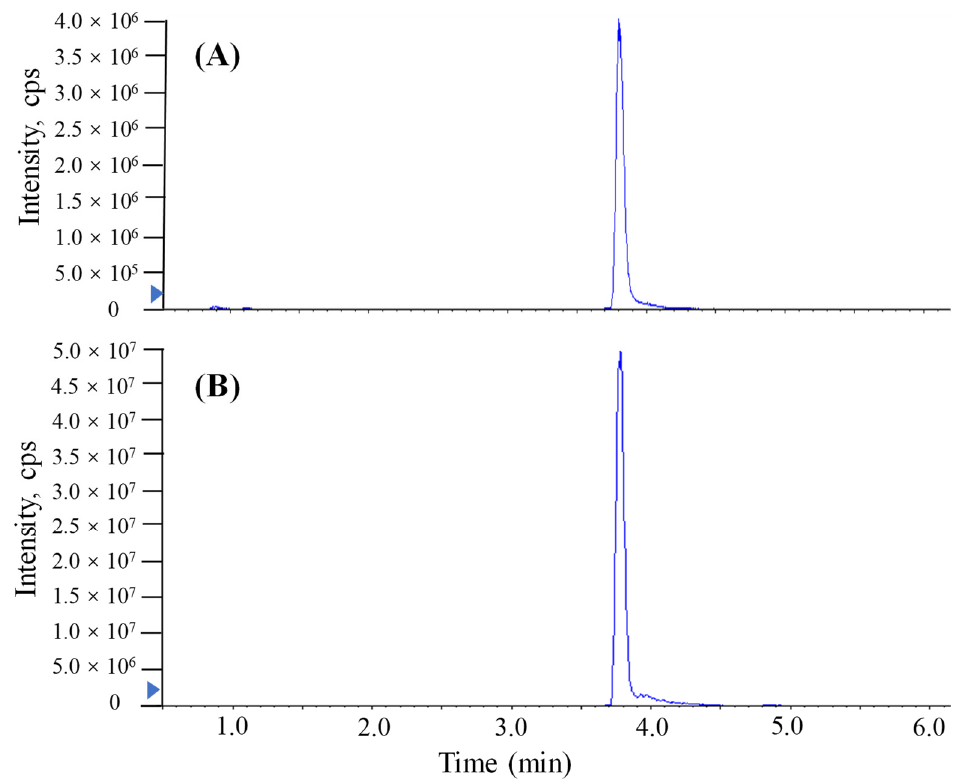
Figure 2. MRM chromatograms of TTX in standard solution (2000 µ g/L) analyzed by UPLC-MS/MS with a Waters ACQUITY UPLC BEH Amide column. ( A ) The method conducted without proton- enhanced ionization. ( B ) The method conducted with proton-enhanced ionization.